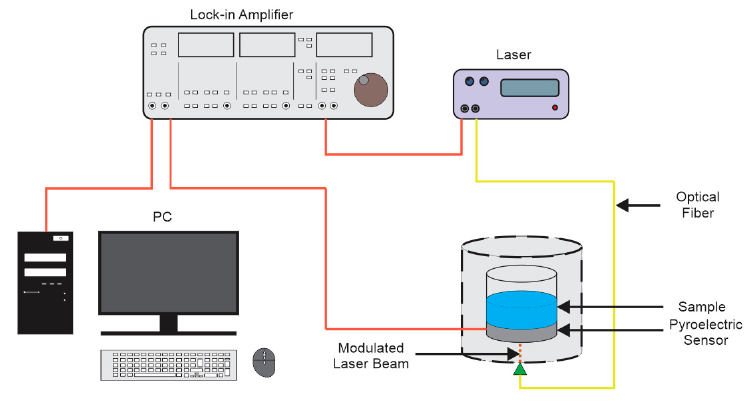
Figure 1. IPPE technique: experimental setup.